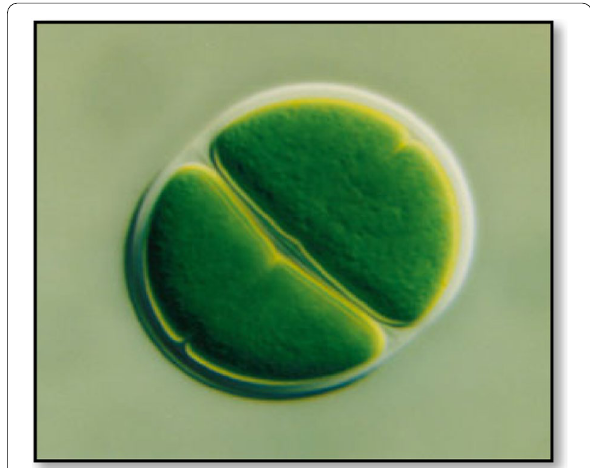
Fig. 3 The structure of a “sheath” of the unicellular Chroococcus sp. [71]